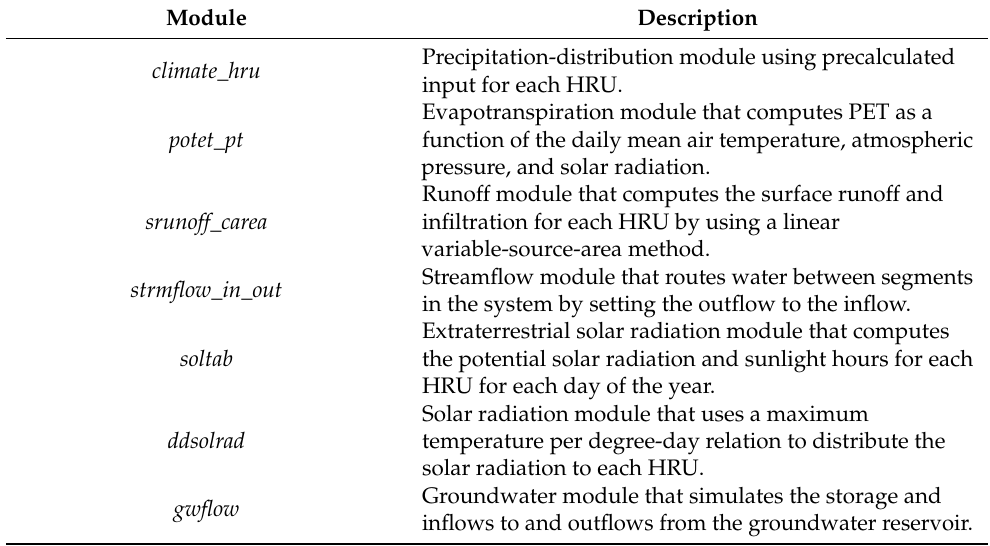
Figure 3. Hydrologic Response Units (HRUs) and stream segments in Puerto Rico PRMS model. Table 2. Precipitation-Runoff Modeling System modules used for setup of the